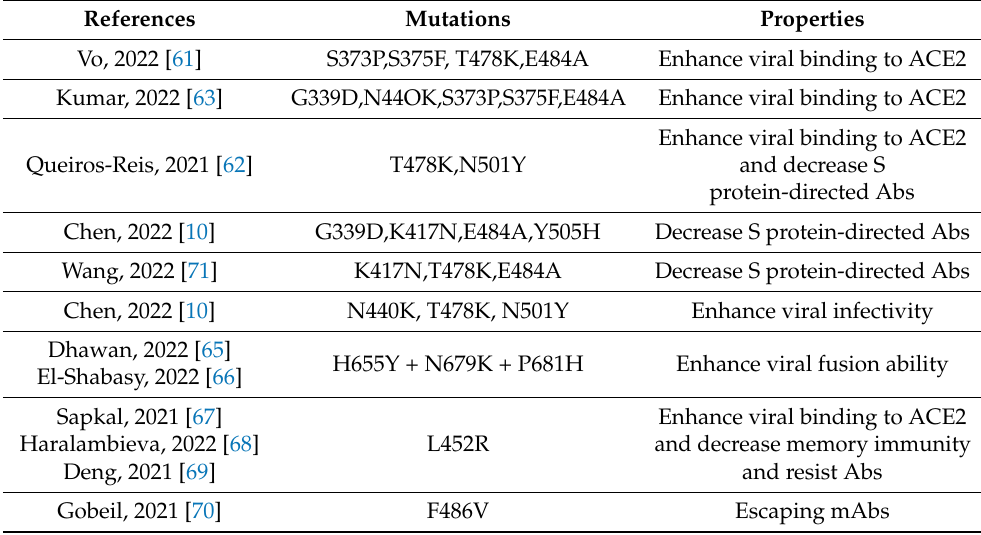
Table 3. Properties of mutations in the